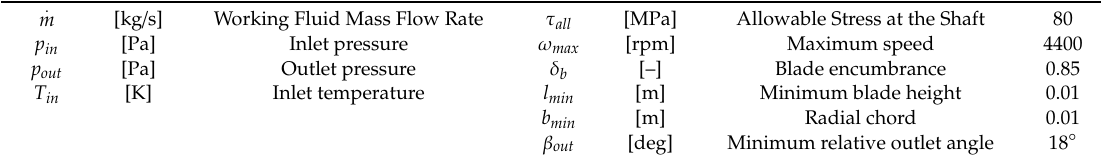
Table 7. Inputs and constraints of the